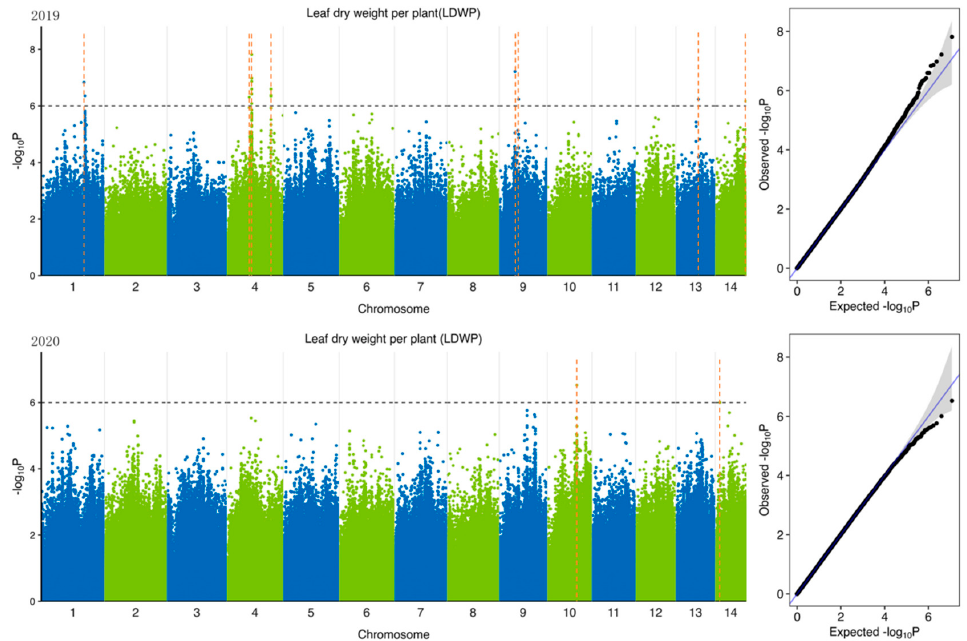
Figure 7. Manhattan plots of GWAS results for leaf dry weight per plant (LDWP) in 2019 and 2020. Notes: Blue and green dots represented SNP (single nucleotide polymorphism) sites on chromosomes, respectively. When the value of − log 10 p was above 6 (gray line), the selected SNP site with significant aboriginality. Orange dotted lines represented the location of SNP loci.